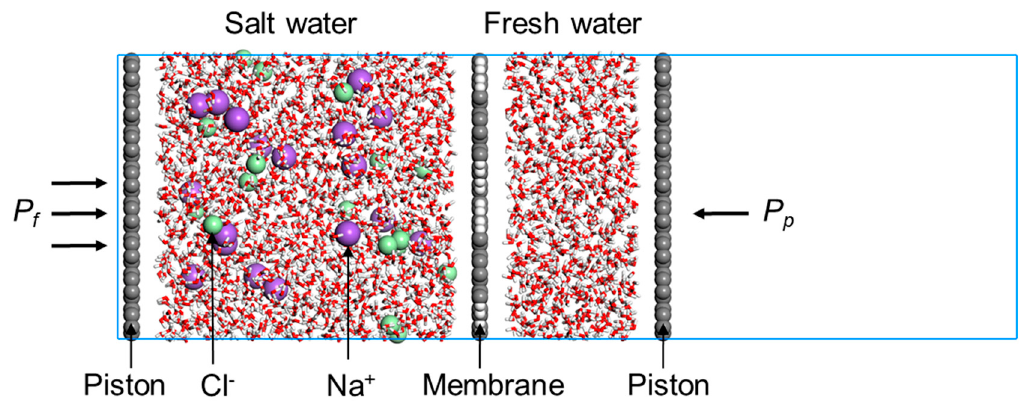
Figure 2. Schematic view of the reverse osmosis (RO) desalination system. PG-TP2 is used as the active membrane layer. Atom color: carbon-gray, hydrogen-white, oxygen-red, sodium-purple, and chloride-green.